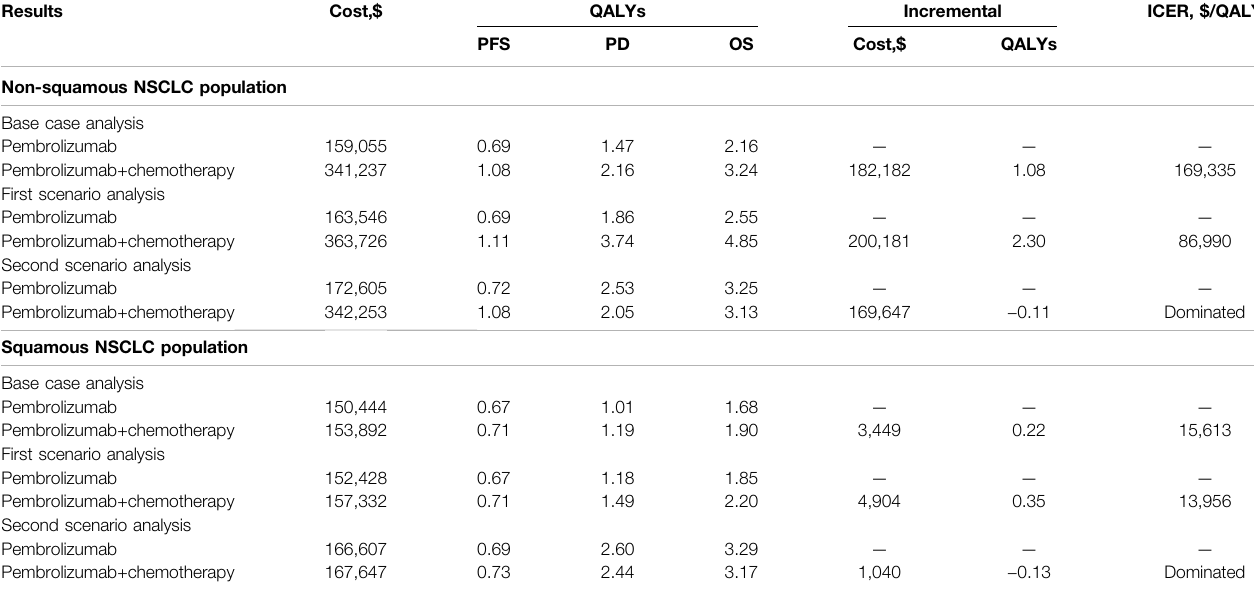
TABLE 2 | Summary